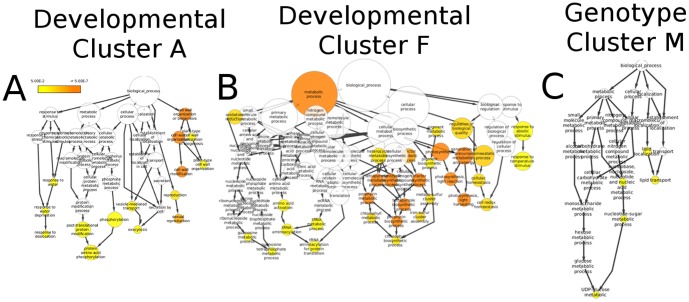
GO enrichment analysis of co-expression clusters.Gene clusters identified in Figure 2 were examined for enrichment of Gene Ontology terms. (A) Developmental cluster A, which exhibited a strong signal for expression in the anthers (see Figure 3), is enriched for GO terms related to sexual reproduction, response to desiccation, and cell wall biogenesis/modification. (B) Developmental cluster F, highlighted by patterns of expression in the leaves, is notably enriched for terms annotated for photosynthesis, response to temperature stimulus, and chlorophyll metabolism. (C) Genotype cluster M exhibits drastic under-expression in the P39 genotype, a sweet corn line, and shows significant GO enrichment in terms related to UDP-glucose as well as nucleotide-sugar metabolism and lipid transport.